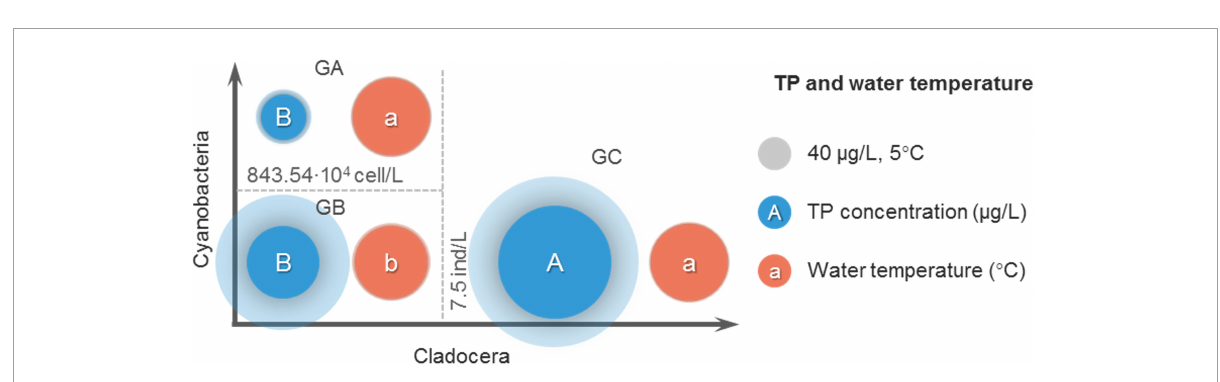
FIGURE7 Average comparison of TP and water temperature among the three groups. No intragroup comparisons were made in this comparison.